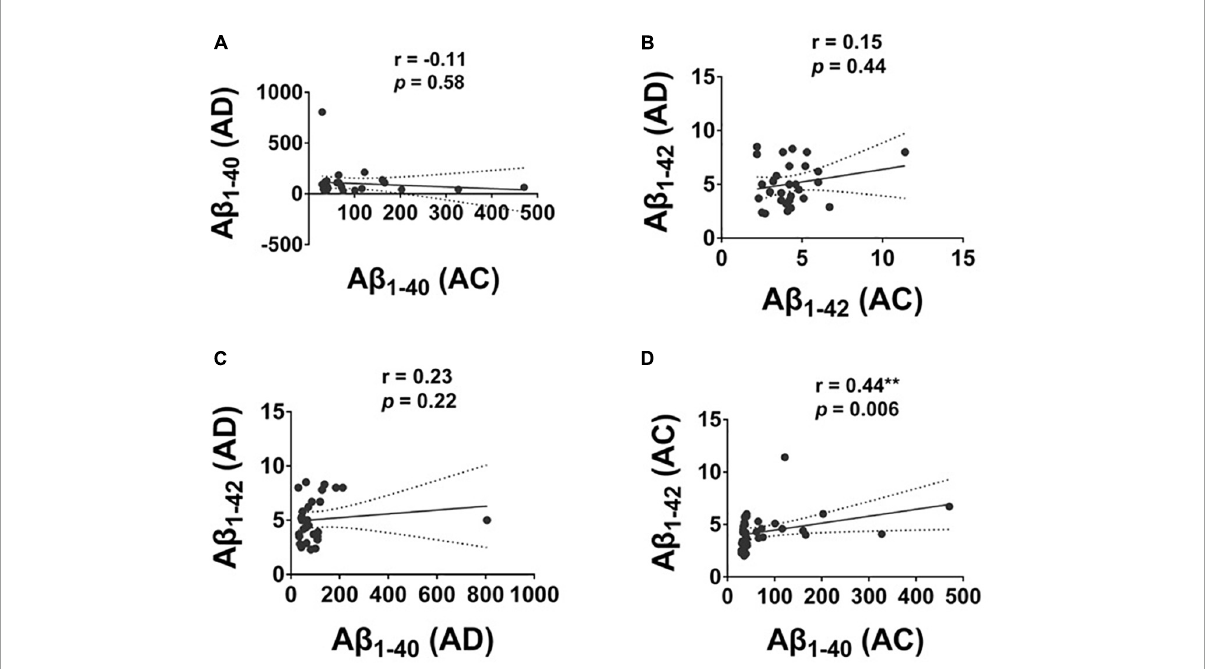
FIGURE3 The correlation of plasma A β 1 - 42 and A β 1 - 40 protein levels in Alzheimer’s disease (AD) and Adult Children (AC) groups. Correlations of plasma (A) A β